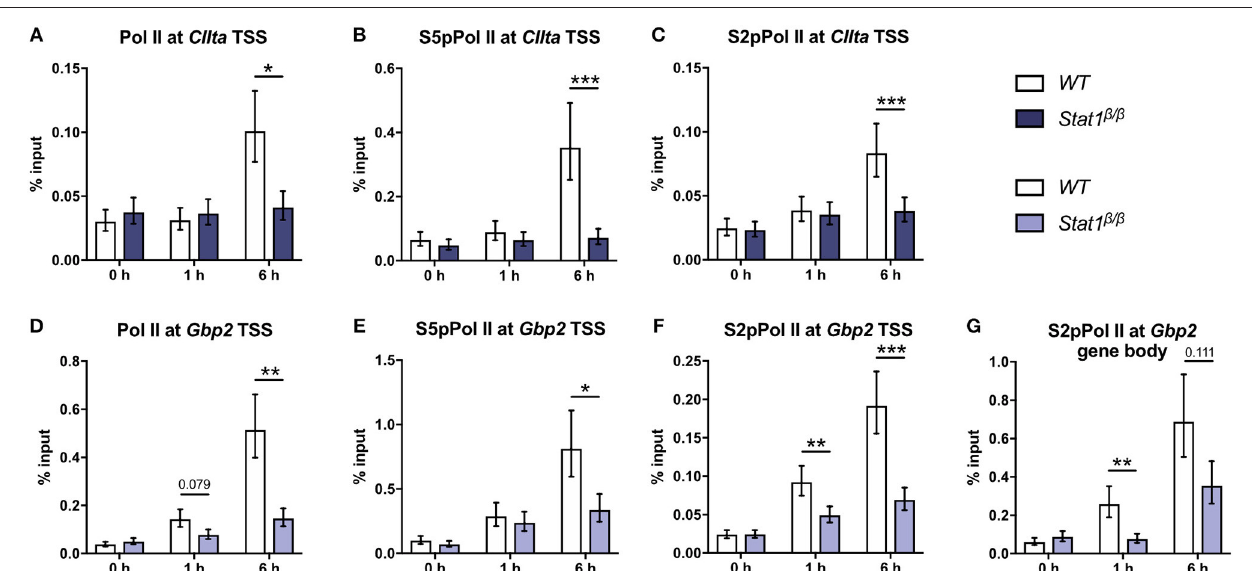
FIGURE 3 | Promoter occupancy of Pol II, S5 phosphorylated Pol II (S5pPol II), and S2 phosphorylated Pol II (S2pPol II) around the CIIta and Gbp2 TSS and of S2pPol II at the Gbp2 gene body. BMDMs from WT and Stat1 β/β mice were stimulated with IFN γ for the times indicated or left untreated (0h). The association of Pol II, S5pPol II, and S2pPol II with the TSS of (A–C) CIIta pIV and (D–F) Gbp2 TSS, and (G) association of S2pPol II with the Gbp2 gene body was determined by ChIP. Data were normalized to the input control. Mean values ± SE from three (D,G) , four (A,B) or five (C,E,F) independent experiments are shown; * P ≤ 0.05 , ** P ≤ 0.01 , *** P ≤ 0.001 . Significances are only indicated for the comparisons between